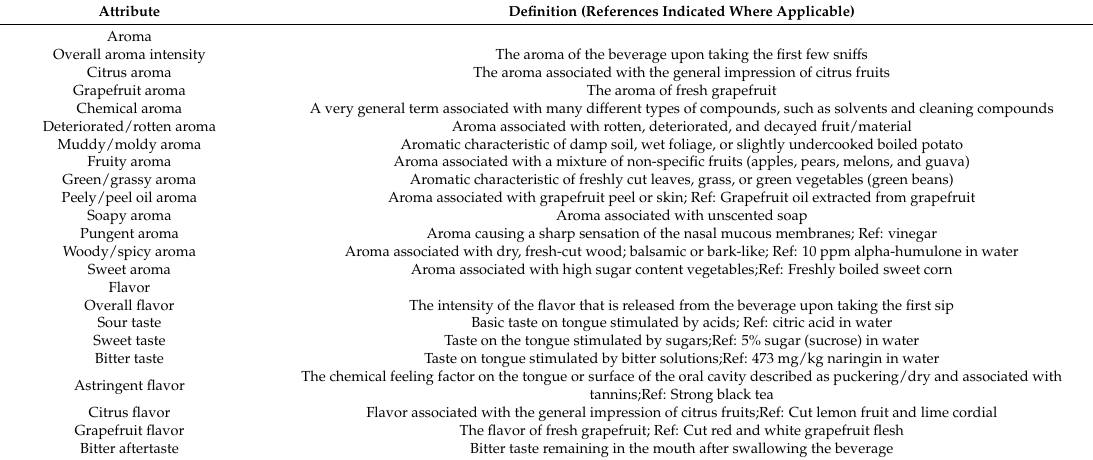
Table 2. Definitions of attributes used for describing the aroma, flavor, and aftertaste of the grapefruit-like